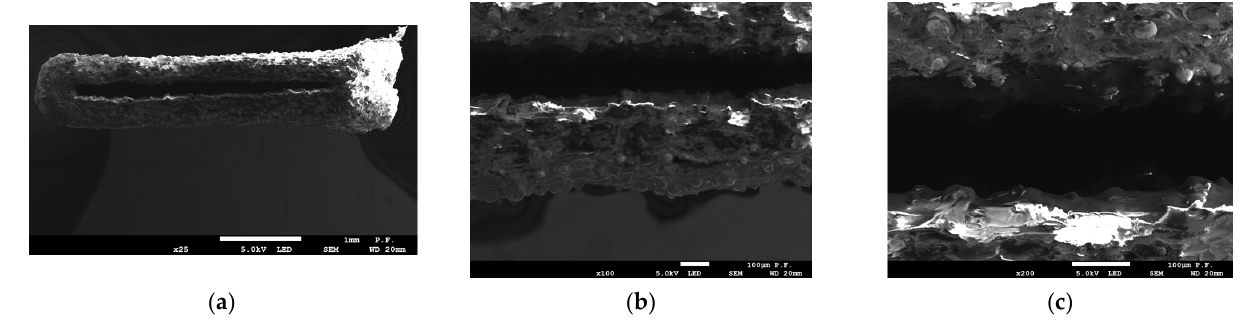
Figure 7. Cross-section of specimen 1.0 2Z composed of PLA + bronze after fracture observed with a scanning electron microscope. Observation direction—perpendicular to the cross-section; ( a ) magnification × 25; ( b ) magnification × 100; ( c ) magnification × 200.